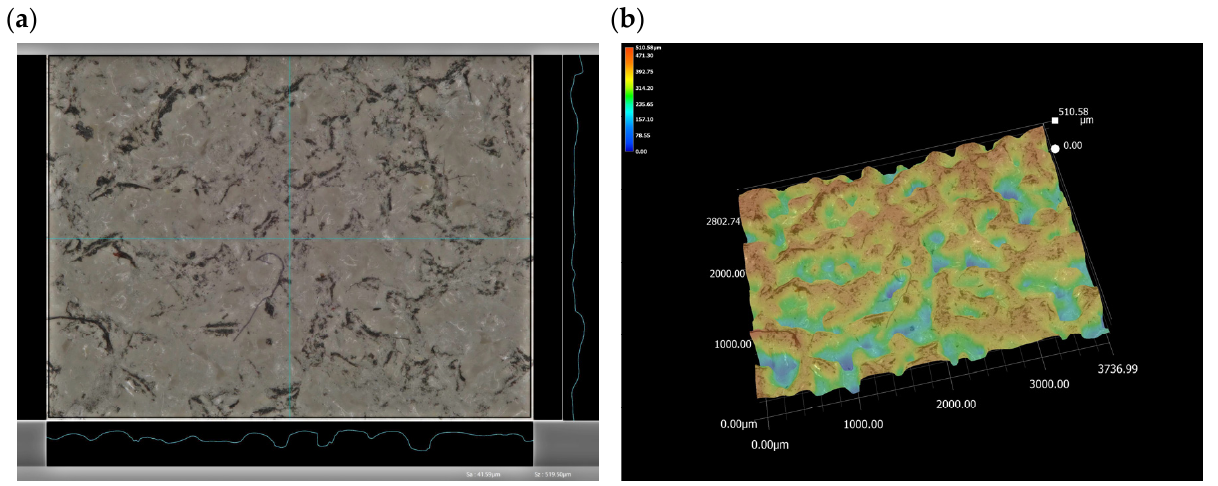
Figure 10. Microscopic view of the active surface of the ceramic grinding wheel: ( a ) 80 × magnification view of the grinding wheel; ( b ) 80 × magnification analysis of the surface topography of the ceramic grinding wheel.